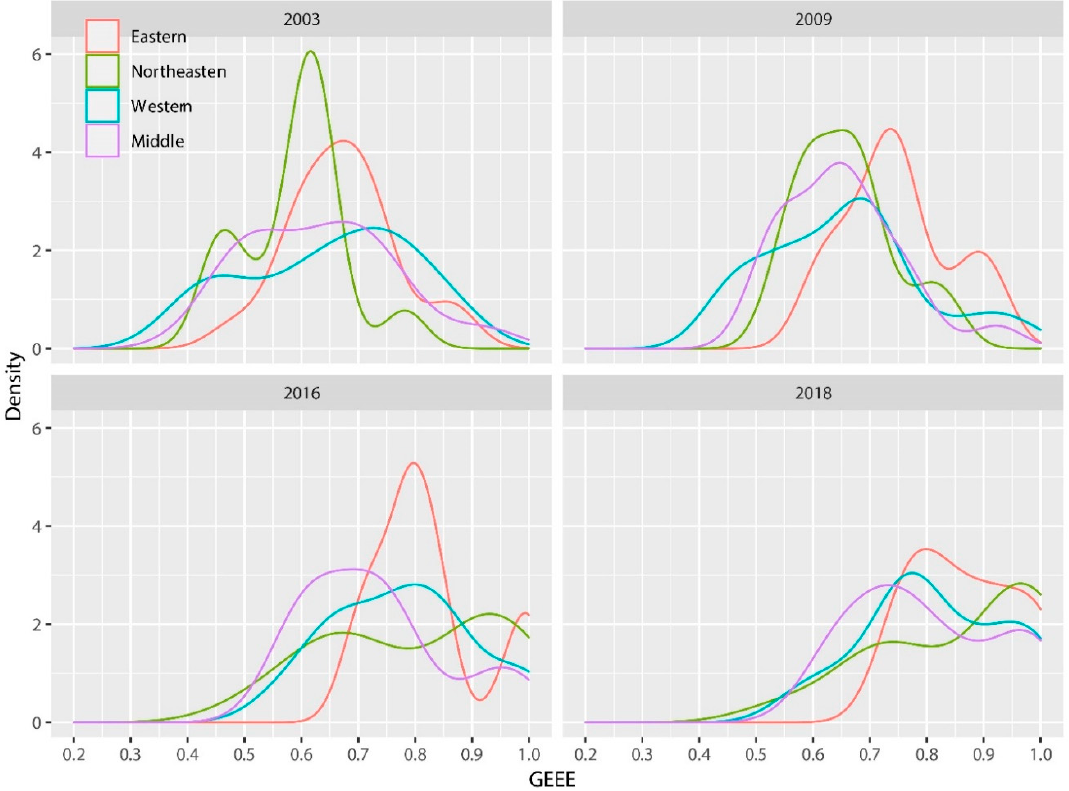
Figure 4. Density distribution of GEEE for classification by region.